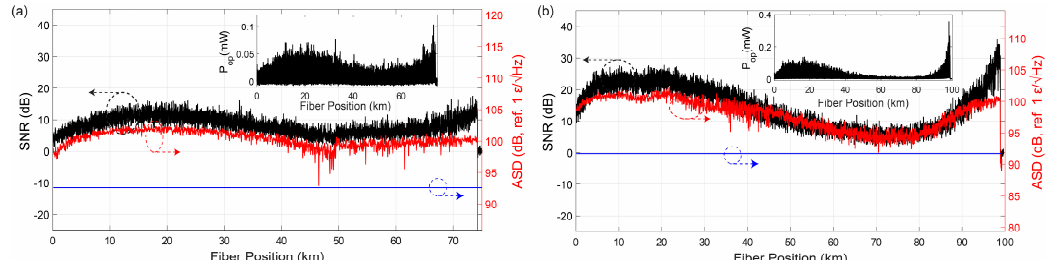
Figure 21. Fibre trace SNR (black), inverted strain ASD noise floor (red), and equivalent laser noise level (blue), with 100 ns FWHM pulses ( τ p ) and 1 kHz pulse repetition rate ( f s , ac ) along: ( a ) 75 km, pulse peak power = 30 mW, without averaging, bi-directional Raman amplification (co-propagating Raman pump = 270 mW, counter-propagating Raman pump = 245 mW); ( b ) 100 km, pulse peak power = 30 mW, with 20 averages of the optical trace, bi-directional Raman amplification (co-propagating Raman pump = 300 mW, counter-propagating Raman pump = 380 mW). Insets show the photodetected traces. The sensor strain ASD noise floor is maintained above 150 p ε / Hz and 400 p ε / Hz,